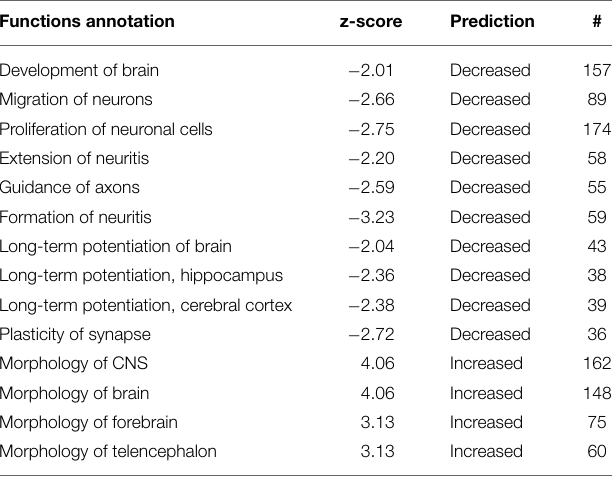
TABLE 5A | Functions annotation for Nervous System Development along with predictions for activation state (z-score). Functions annotation z-score Prediction